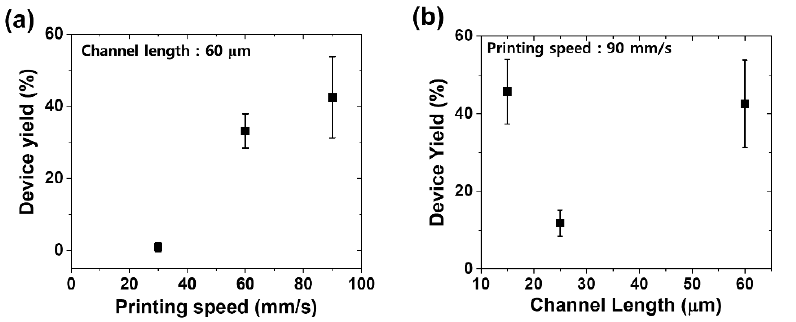
Figure 9. Statistical maps generated from PICR2R-TFT measurements of the 26 × 38 SWCNT-TFT arrays with a printing speed of 90 mm/s containing channel lengths of 60 µm at various lengths of a 6 m printing run: ( a ) 0 m, ( b ) 3 m, and ( c ) 6 m (light box: “pass”, dark box: “fail”).